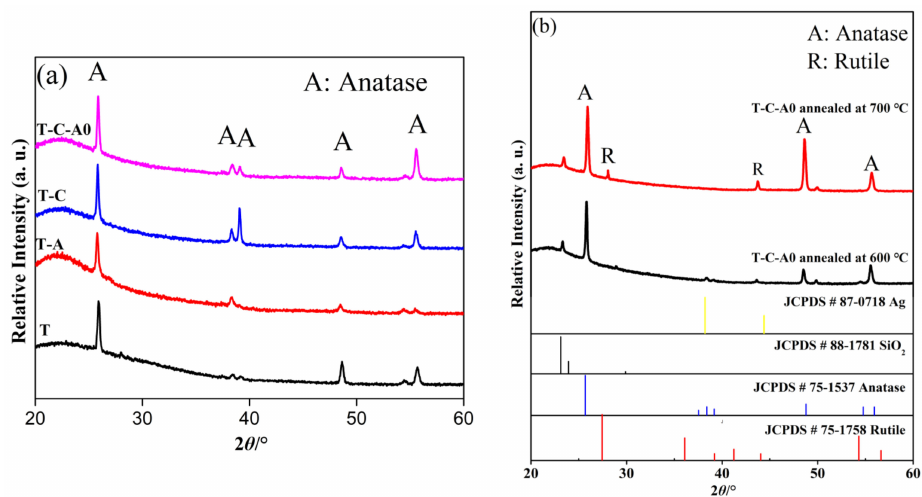
Figure 7. X-ray diffraction (XRD) patterns of ( a ) T and T-composite films and ( b ) T-C-A0 films annealed at different temperatures.